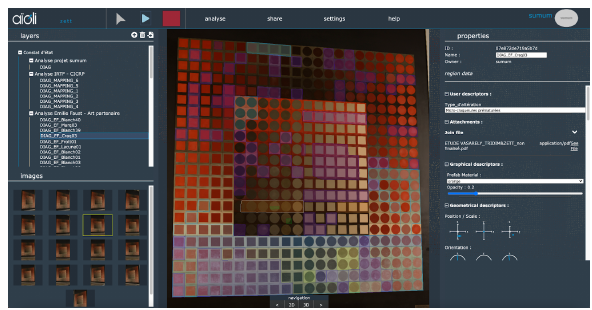
Figure 4. Digital cartography of the alterations within AIOLI on “Zett” data set